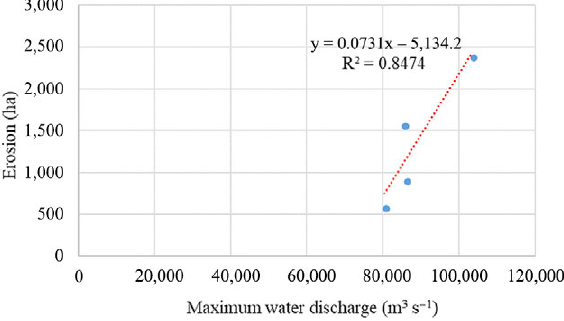
Fig. 6. Relationship between maximum water discharge and erosion ( data source: BWDB 2013, CEGIS